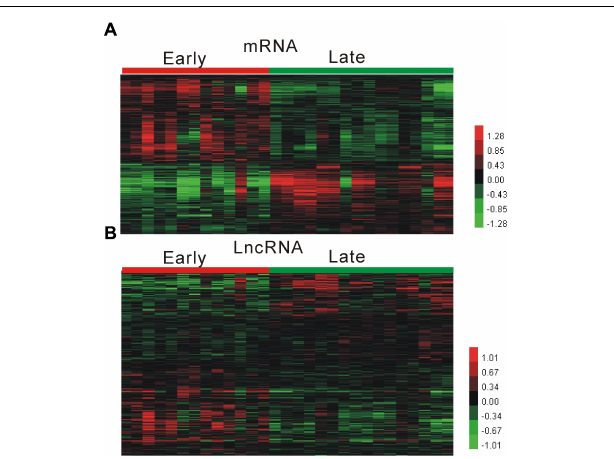
FIGURE 1 | Identification of atherosclerosis progression related mRNAs and lncRNA. (A,B) Hierarchical clustering analysis shows differential mRNAs (A) and lncRNAs (B) expression in advanced atherosclerosis samples compared to early atherosclerosis samples by using